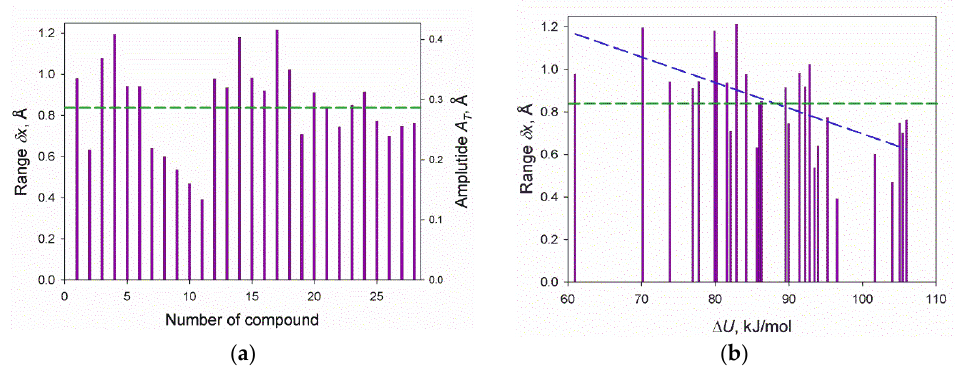
Figure 2. Calculated ranges 𝛿𝑥 and amplitudes A T = 𝛿𝑥/√𝜋𝑒 (see Supplementary Calculations) for molecular movements in the 28 considered crystals (see Supplementary Table S1) arranged in the standard order, see Table S1 ( a ) and the change in ∆𝑈 , the potential energy of sublimation ( b ). The blue dashed line in ( b ) is the best-fit line. The green horizontal dashed line denotes the mean value, δ x = 0.84